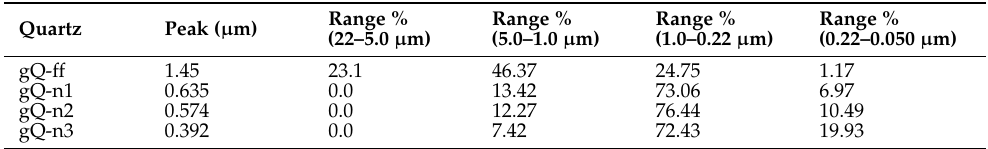
Figure 7. Size distribution of the fine-fractured quartz (gQ-ff) and nanoquartz samples (gQ-n1, gQ-n2, and gQ-n3) that were dispersed in water and probe-sonicated. Size distribution of the four samples analyzed by DCS, expressed as relative wt.% ( A ). Variation of the particle population in the micrometric, submicrometric, and nanometric domains, reported as relative number of particles detected by DCS ( B ). Hydrodynamic size expressed as relative intensity distribution ( C ) and relative number distribution of particles ( D ) of gQ-n3 dispersed in water (with or without post dispersion filtering through a 220 nm porous membrane), and in different biologically relevant media, i.e., Triton X (TRX), dioctyl sulfosuccinate sodium salt (AOT), bovine serum albumin (BSA), phosphate buffered saline (PBS, 10 mM, pH 7.4), artificial phagolysosome fluid (ALF, pH 4.5). Analysis was performed by DLS. FE-SEM micrographs of gQ-n3 after filtration through 220 nm pore size filter ( E , F ). Table 2. Particle size distribution (PSD) of the milled quartz samples that were dispersed in water, probe-sonicated, and measured by